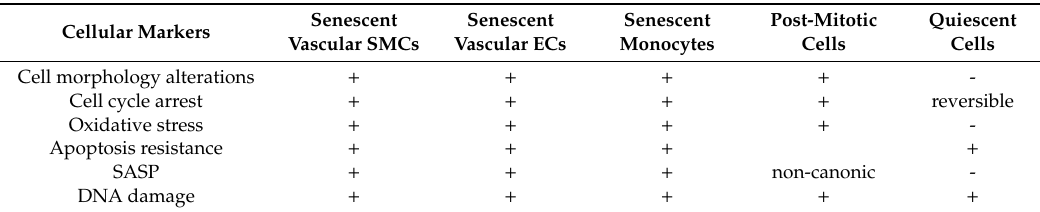
Table 3. Comparison of di ff erent markers exhibited by senescent vascular and post-mitotic cells as well as quiescent